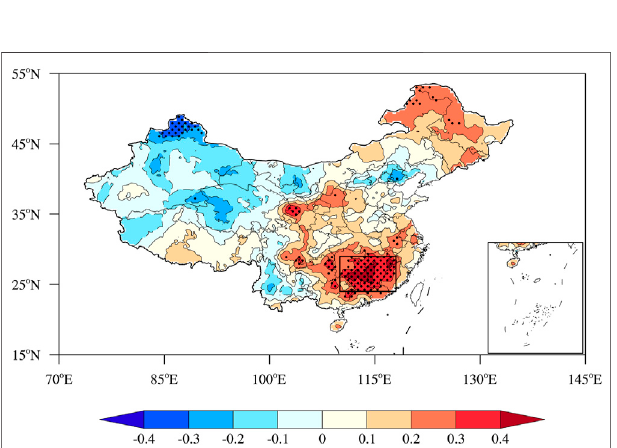
FIGURE 3 | Correlation coef fi cients between the APOI and September precipitation anomalies over China after the removal of the ENSO signal (stippled regions indicate statistical signi fi cance above the 95% con fi dence level).